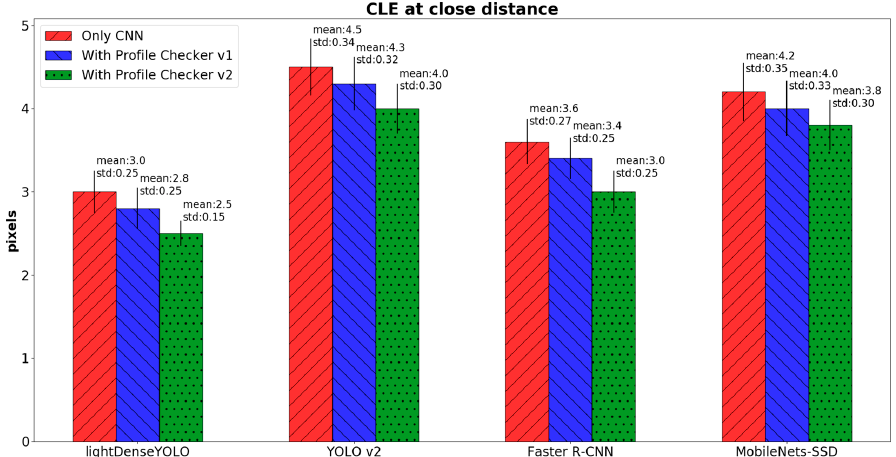
Figure 17. Comparison of CLE of close-distance images of various methods.